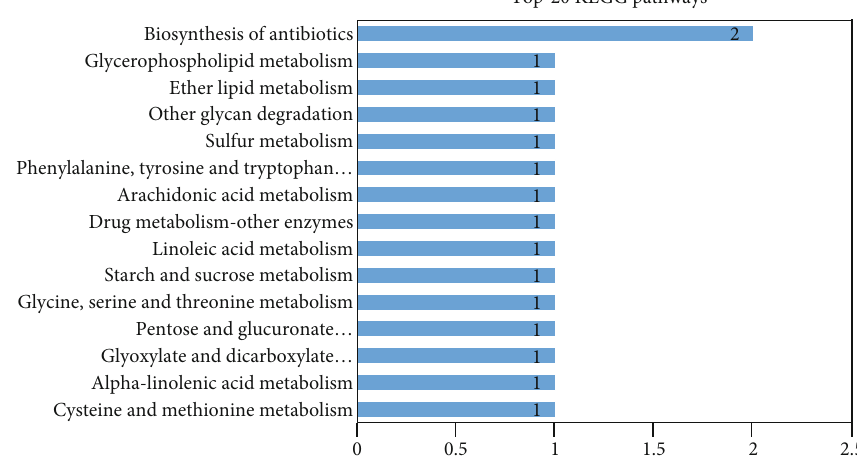
Figure 8: Top 20 downregulated KEGG pathways in C. tetragonoloba under drought stress.